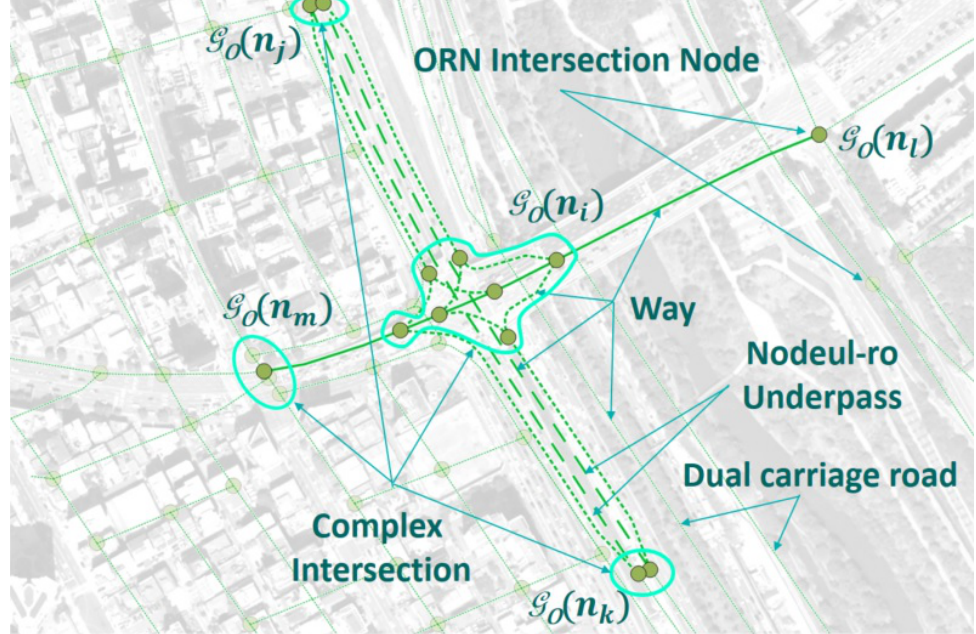
Figure 2. ORN graph representation around Yeoui2-gyo intersection.